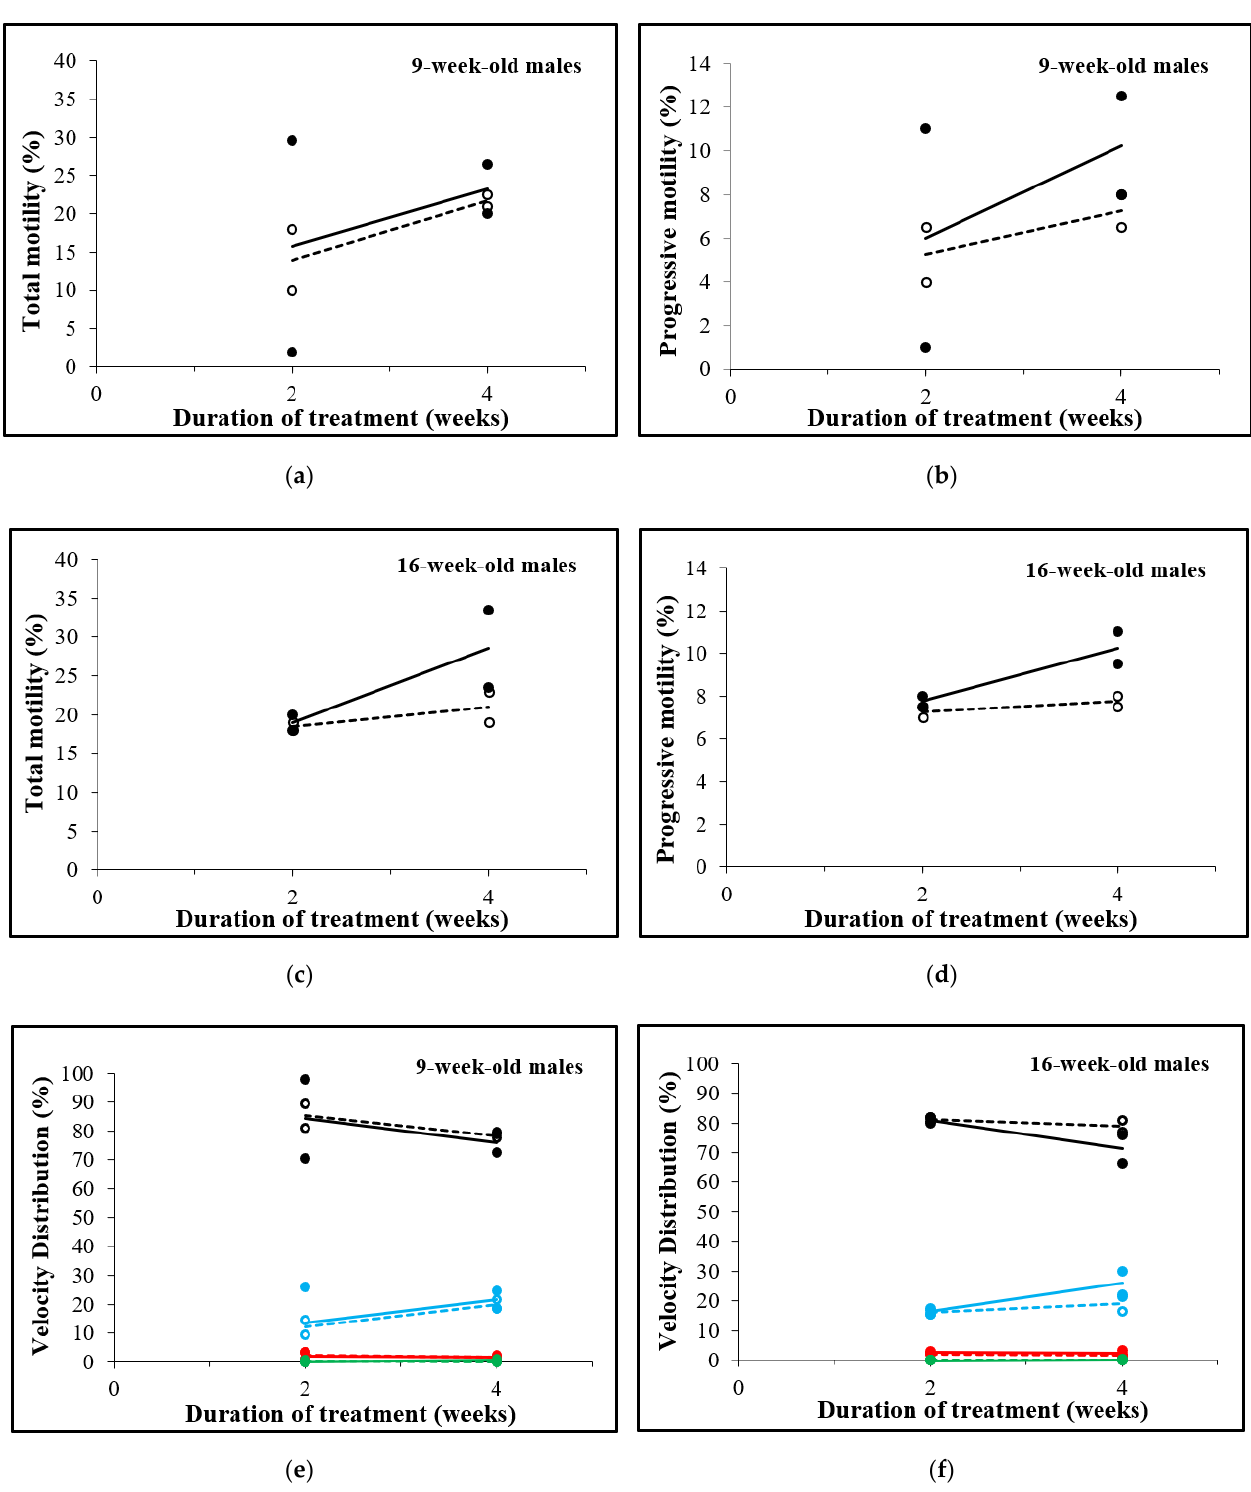
Figure 5. Total motility, progressive motility, and velocity distribution (rapid: blue lines; medium: red lines; slow: green lines; and static: black lines) of spermatozoa from 9-week-old ( a , b , e ) and 16-week-old males ( c , d , f ) treated (continuous lines, single values are shown in solid circles) or not treated (dotted lines, single values are shown in open circles) with D-Asp. The results are shown as the mean of two straws measured in duplicate each.